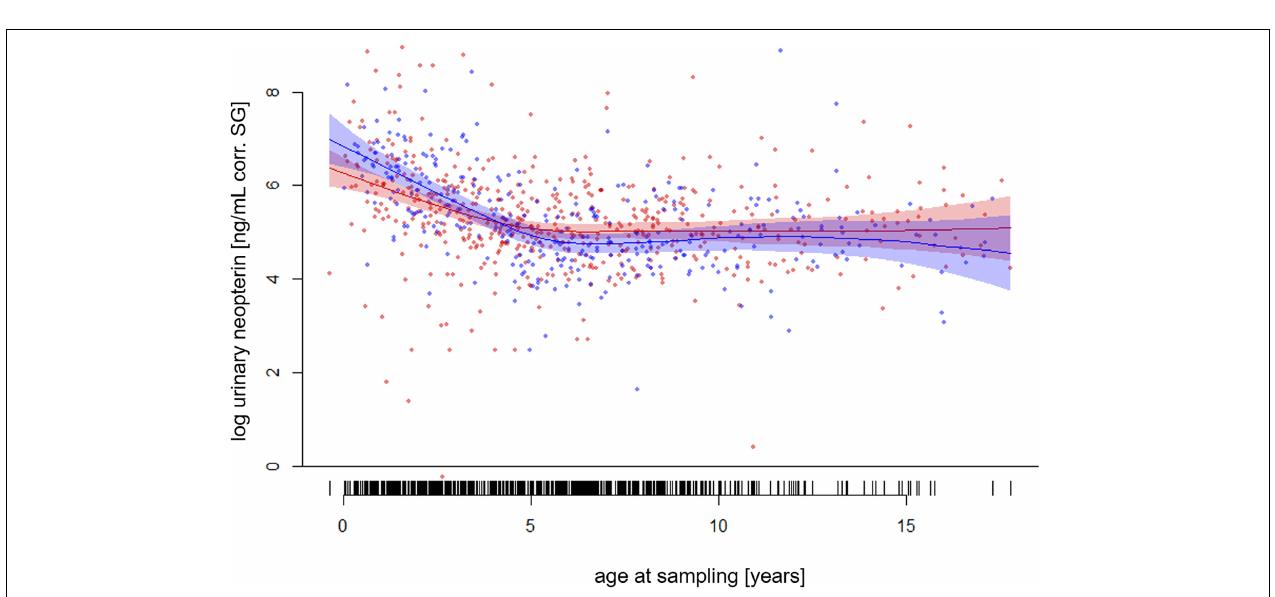
FIGURE 1 | Log-transformed urinary neopterin levels corrected for specific gravity (corr. SG) obtained from wild (left) and zoo-housed (right) bonobos in relation to chronological age at sampling. Each filled circle represents a sample: females in red, males in blue. Lines represent the fitted sigmoidal model for the data set. Shaded areas represent bootstrapped 95% confidence intervals for expected urinary neopterin levels. Total N = 806 urine samples, N wild = 578 samples, N zoo − housed = 228 samples.